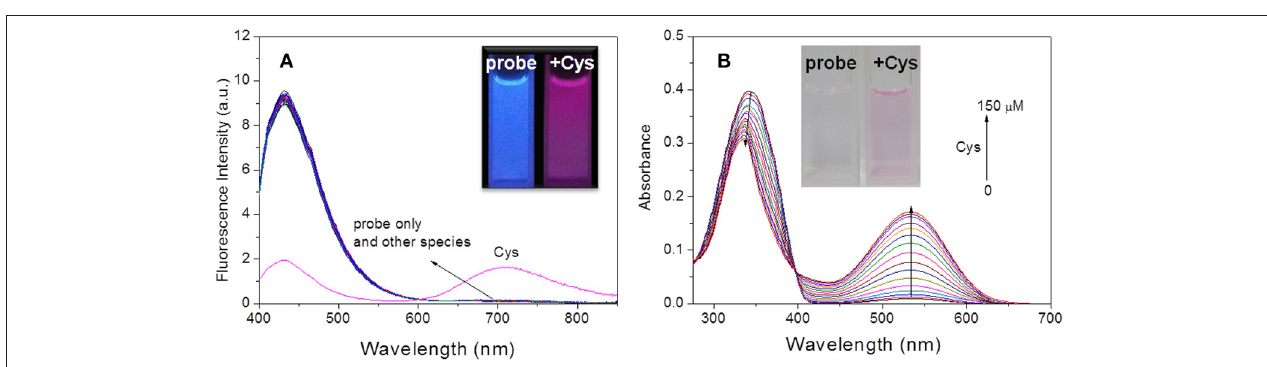
FIGURE 1 | Fluorescence spectra of HBT-Cys (10 µ M) in the absence and presence of 15 equiv. of various amino acids and biologically relevant species (A) . Absorption spectra of HBT-Cys (10 µ M) upon addition of 0–150 µ M Cys (B) . Insets are the fluorescence (A) and solution (B) color change of the probe in the absence and presence of Cys, where the fluorescence in (A) was obtained by exposing the solution under UV lamp at 365-nm. The measurements were performed in aqueous PBS buffer solution (pH = 7.4, 50% DMF) and the excitation wavelength was 396nm for fluorescence measurement.